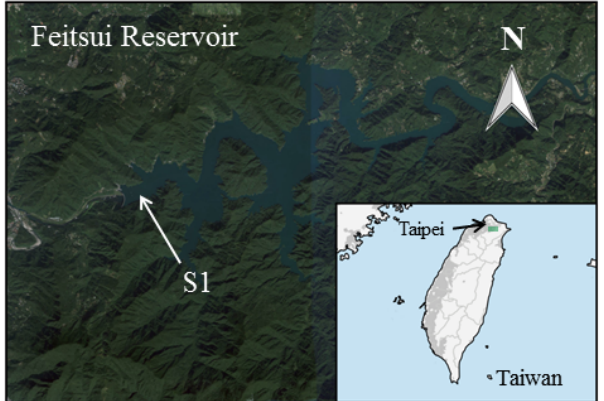
Figure 1. Location of Feitsui Reservoir in northern Taiwan. Small green rectangle indicates the enlarged satellite map of the reservoir with the position of the long-term station S1 near the dam